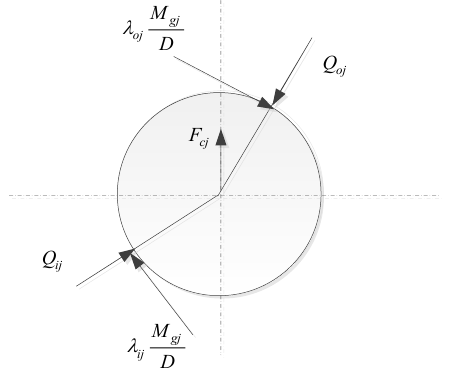
Figure 5. Force analysis of the j th rolling